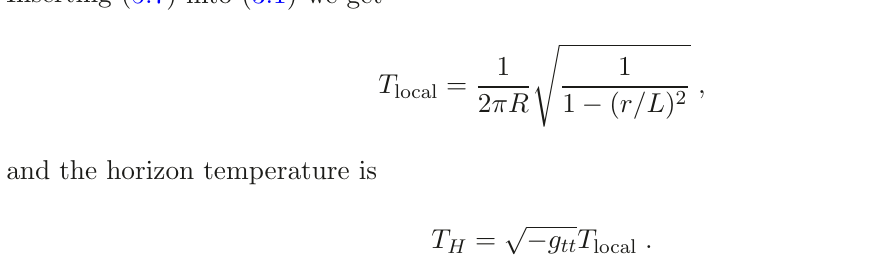
Figure 4 . Geometry of Rindler-AdS d +1 space. The shaded region is a surface of constant R , which covers the static patches of a pair of antipodal de Sitter observers. τ and ρ are the time and radius in global coordinates. The Rindler-AdS region extends only up to τ = The arrow in the right shaded region points in the direction of ∂ t , whose orbits are a Rindler/de Sitter observer’s worldline; the arrow is reversed for the antipodal observer. Except at ρ = 0 each point in the interior corresponds to a S d − 2